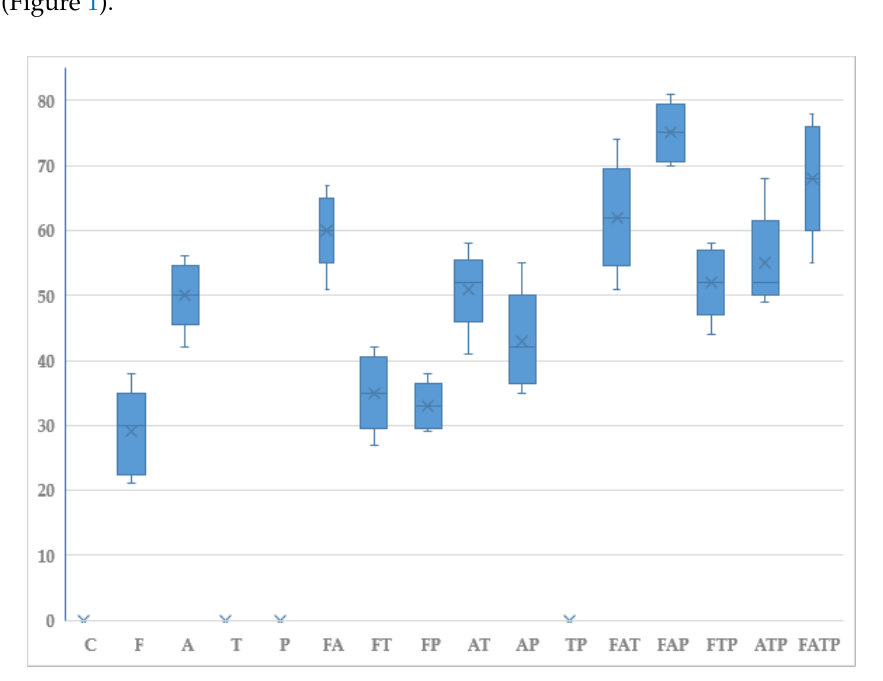
Figure 1. AM root colonization (%) in the sixteen treatments. C—Control, F— Funelliformis mosseae , A— Acaulospora laevis , T— Trichoderma viride , and P— Pseudomonas fluorescence .